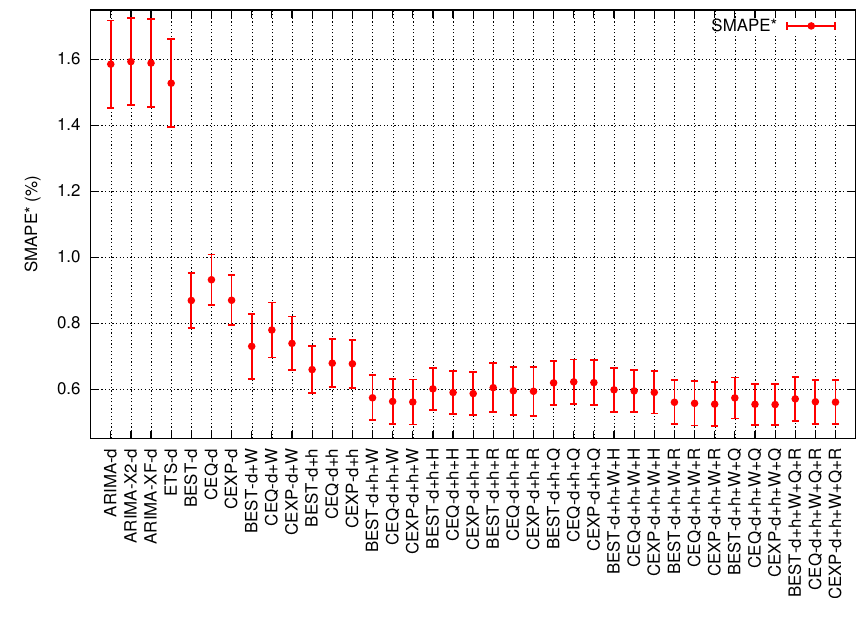
Table 4. Combination weights of every input size of d for the COMB-EXP models given tested covariates combinations. All co-variables have an input size of 5 ( 75 min). Bold numbers are the best input